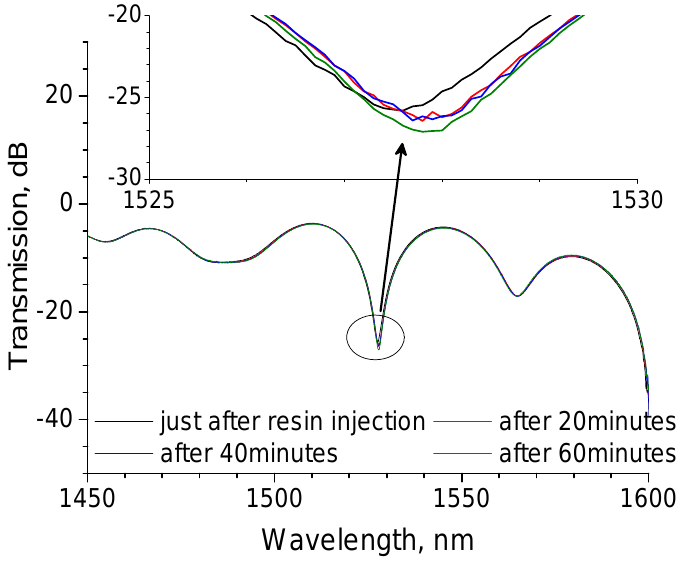
Figure 14. Change in the transmission spectra of an LPG in the resin cure process in which the temperature was saturated. The upper figure is an enlarged view of the transmission spectra in the wavelength range from 1,525 to 1,530